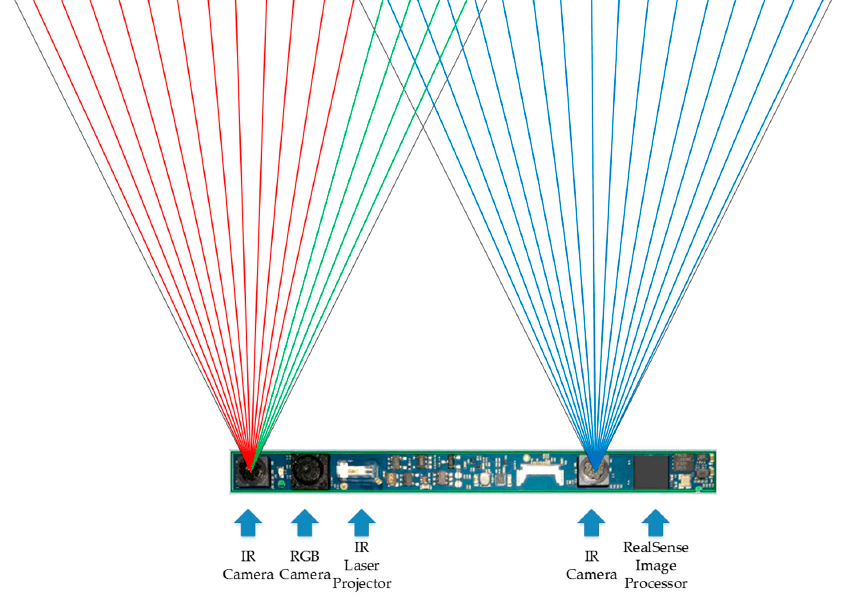
Figure 3. Horizontal field angle of IR cameras.